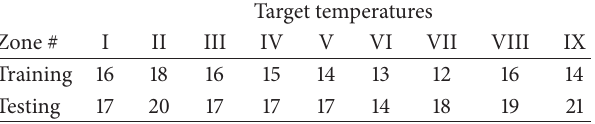
Table 2: Training and testing zones’ target temperatures.